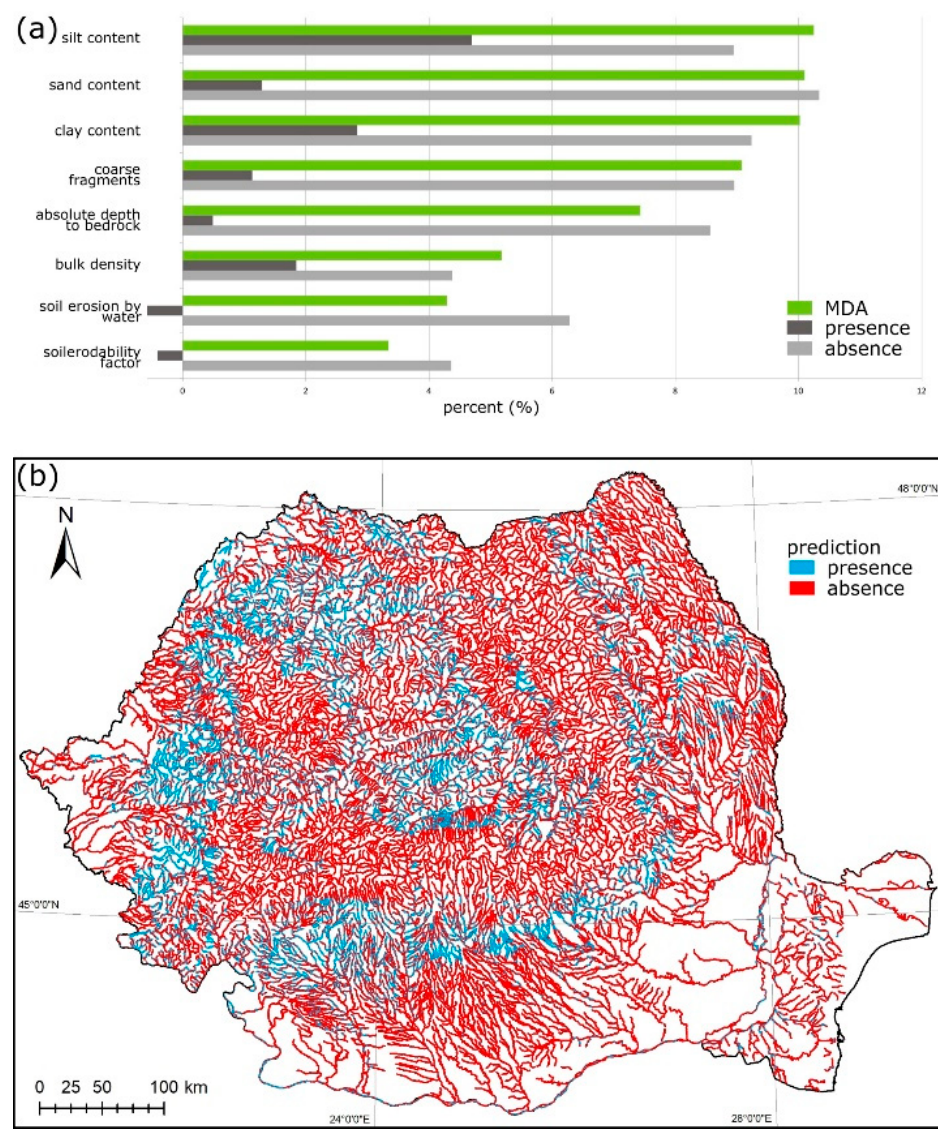
Figure 4. ( a ) Mean decrease in accuracy of soil-related factors for predicting Astacus astacus species distribution. ( b ) Prediction map of A . astacus species distribution based on soil-related factors.